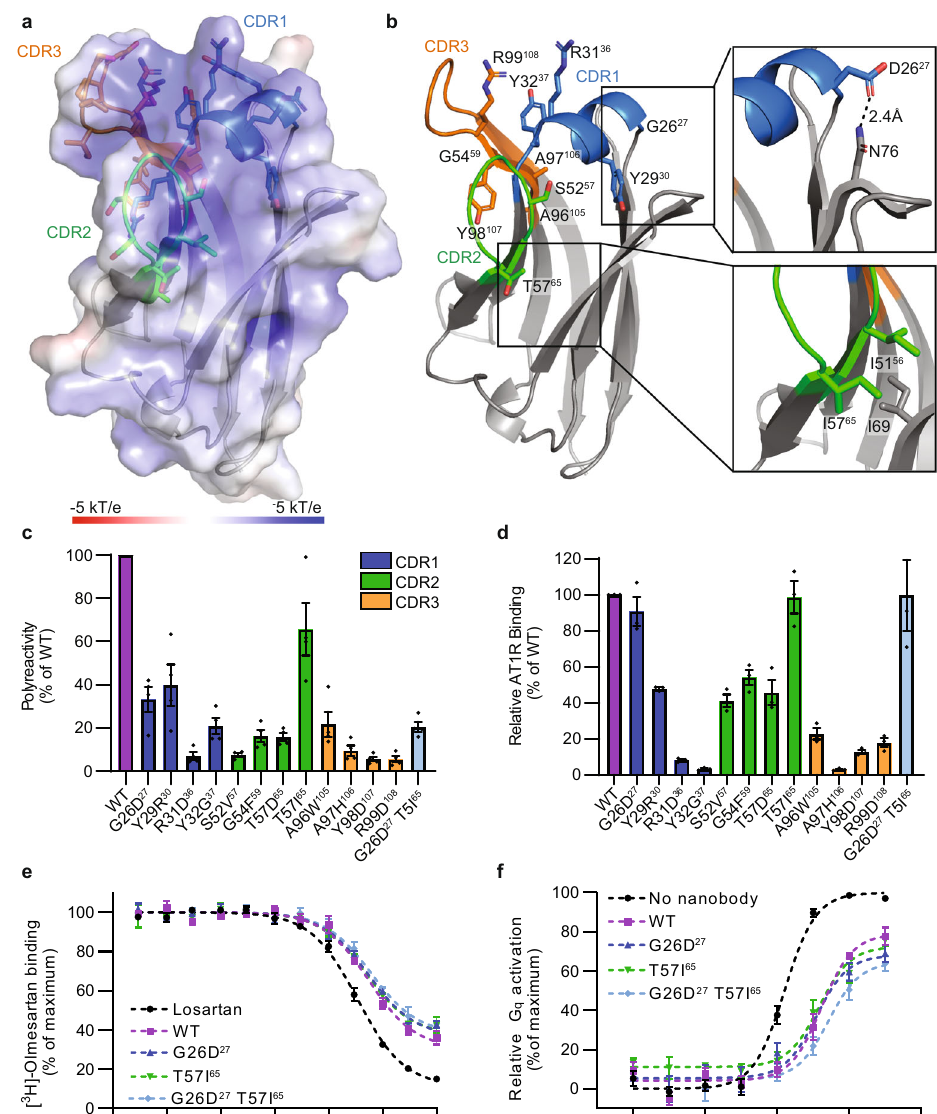
Fig. 6 | Development of AT118i4h32 variants with reduced polyspeci fi city. a Electrostatic surface of AT118i4h32. CDR1, CDR2, and CDR3 are colored blue, green,andorange.AllpositionssubstitutedtoproducevariantsofAT118i4h32with reduced polyreactivity are shown in sticks with atomic coloring b AT118i4h32 structure as colored in a. G26D 27 and T57I 65 substitutions are boxed. c PSRstaining ofyeast displaying AT118i4h32variants. Allamino acid substitutions decrease polyreactivity. Datain c comprise the mean+/ − SEM offour independent experiments, each performed in technical triplicate. CDRs are colored as in a . d Binding of AT118i4h32 variants to HEK293 suspension cells expressing FLAG- AT1R. Cells were stained with AT118i4h32-V5-His variants, AlexaFlour-488 con- jugated anti-FLAG, and AlexaFlour-647 conjugated anti-V5 antibodies, then ana- lyzedby fl owcytometry.Dataindistheaverageofthreeindependentexperiments